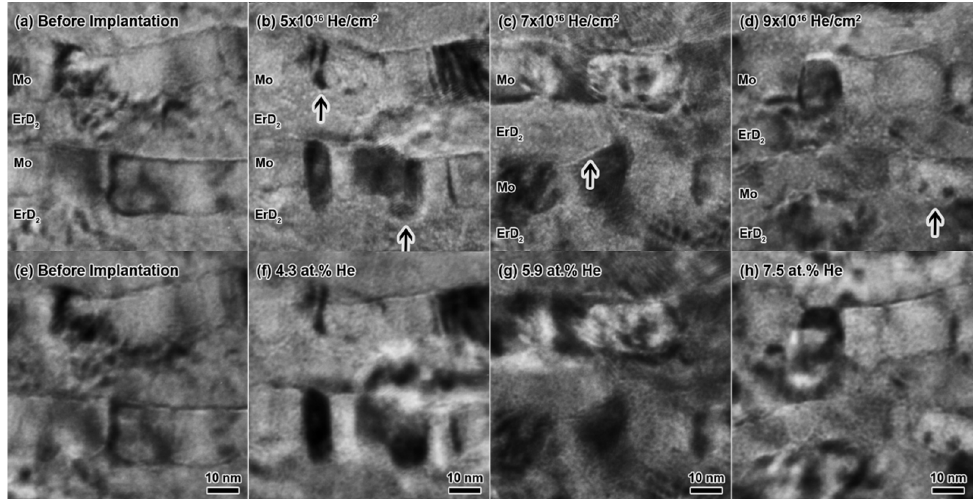
Figure 3. BF TEM images taken during the in-situ implantation at ( a – d ) − 1 µm and ( e – h ) +1 µm defocus. Images were recorded 0° tilt in slightly different locations after several fluences. Bubbles are present along interfaces and within layers in ( b / f ), ( c / g ), and ( d / h ). Arrows indicate some examples of bubble nucleation at multilayer interfaces.